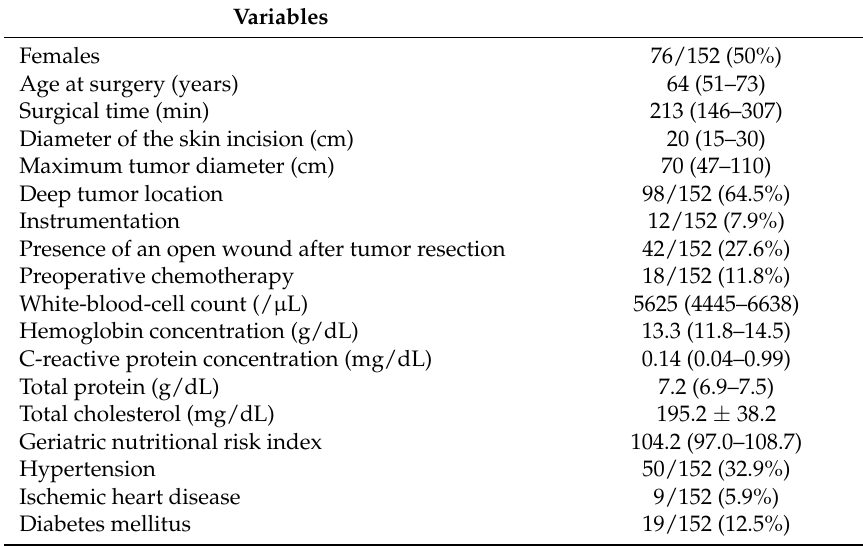
Table 1. Demographic data of patients with soft tissue sarcoma.